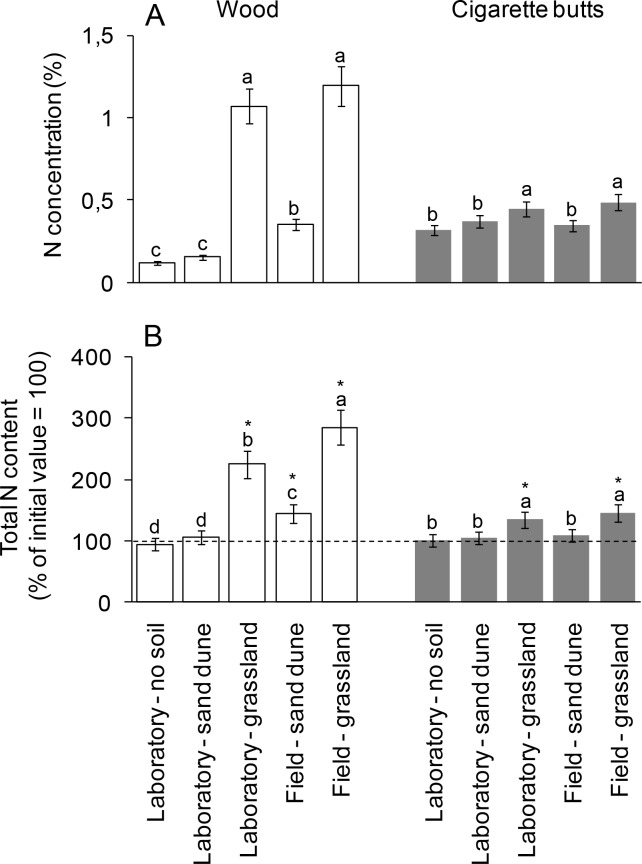
Nitrogen concentration and transfer in wood sticks and cigarette butts.Nitrogen concentration (A, expressed as percentage) and total content (B, expressed as a percentage of initial value fixed at 100%) after 720 days of decomposition in laboratory and field conditions in wood sticks and cigarette butts. Initial N concentration was 0.10% and 0.21% for wood sticks and cigarette butts, respectively. Data refer to mean ± standard deviation; different letters indicate statistically significant differences within each material (Duncan’s test at P < 0.05). Materials showing total N content significantly higher than 100 (t-test with Bonferroni’s correction for multiple comparison, P < 0.005) are marked with * indicating N transfer from the soil.